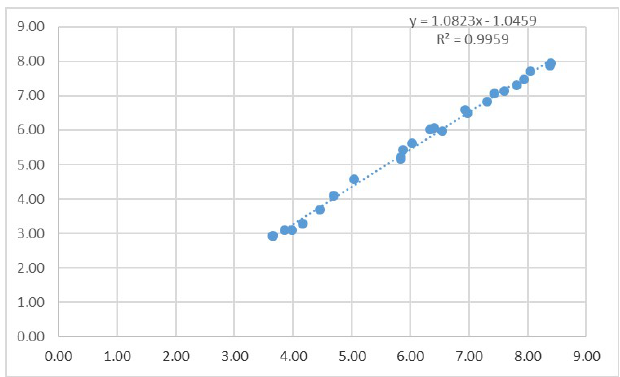
Figure 2. The 30-year ( X ) vs. 15-year ( Y ) fixed rate mortgage average in the United